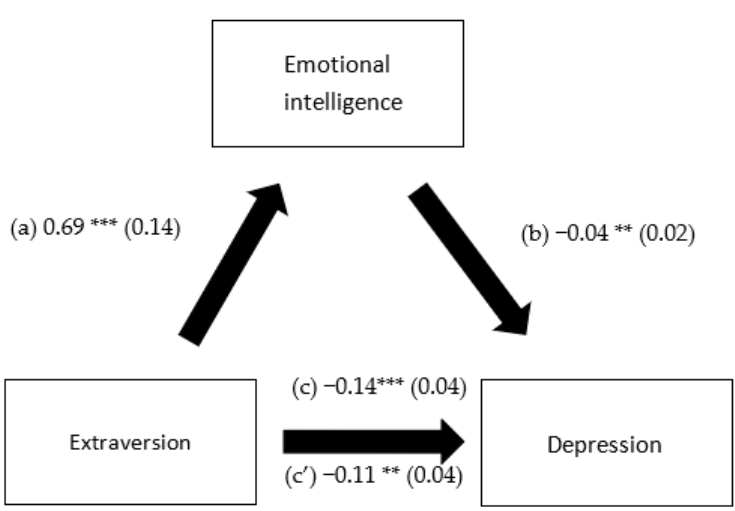
Figure 2. (a) Relation between openness to experience and emotional intelligence (R 2 = 0.294); (b) relation between emotional intelligence and depression (R 2 = 0.284); (c) total effect of the relation between openness to experience and depression (R 2 = 0.270); and (c’) direct effect of the relation between openness to experience and depression. Numbers are displayed as regression coefficients (standard error). * p < 0.05; *** p < 0.001.